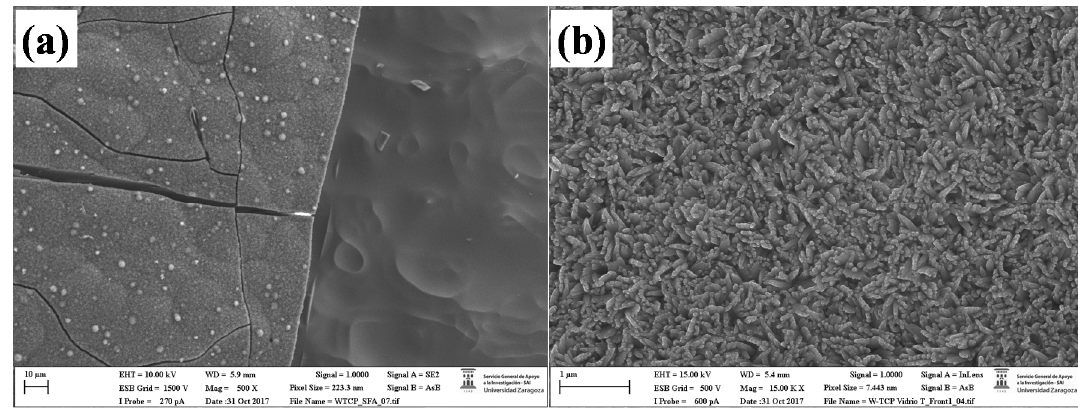
Figure 4. SEM micrographs of the W-TCP eutectic sample after a one-month immersion in SBF. General view ( a ), and a detail of the layer developed on the surface ( b ). Table 2. EDX compositional analysis in at % of both the W-TCP glass and surface layer.